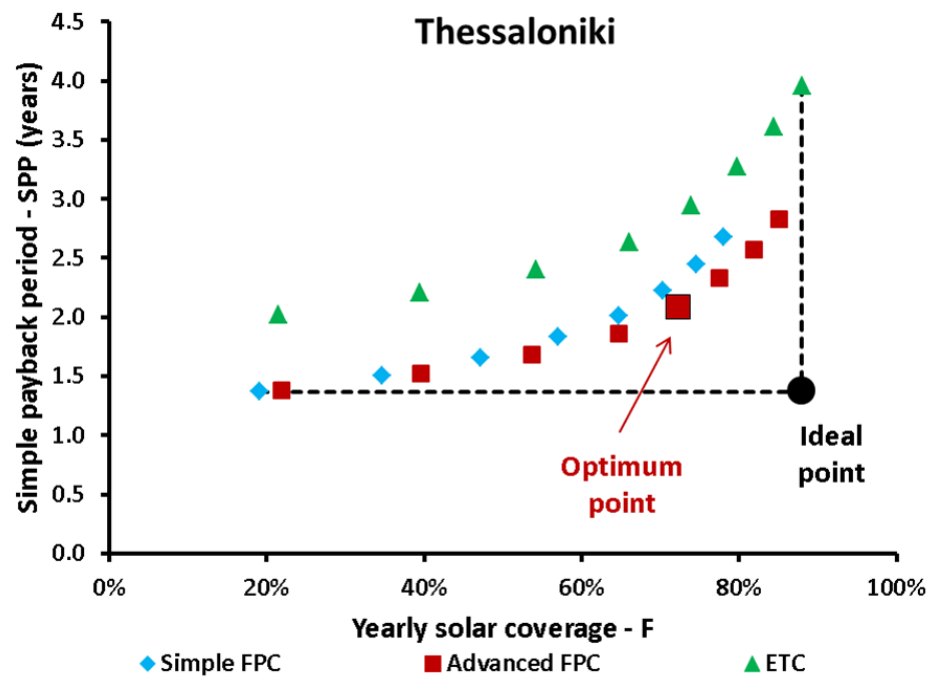
Figure 30. Multi-objective optimization for the Thessaloniki city—Zone C.